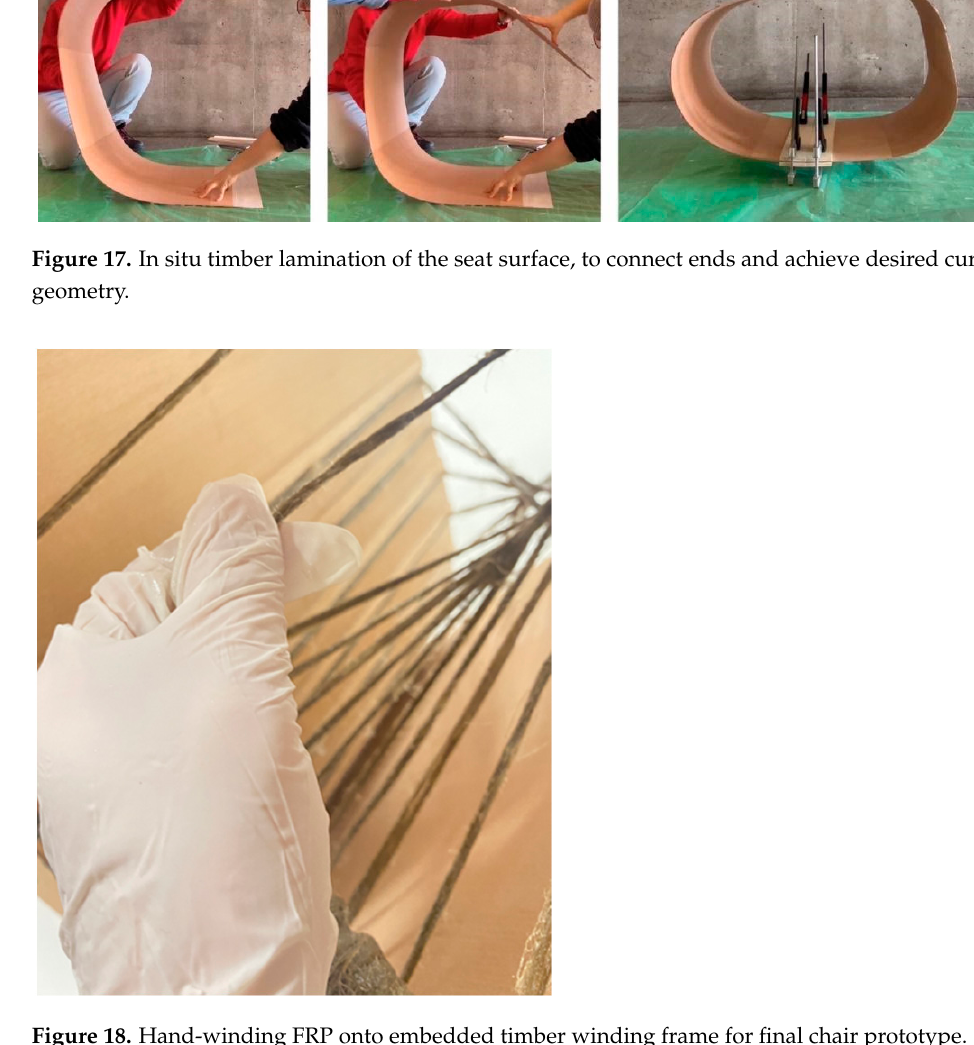
Figure 18. Hand-winding FRP onto embedded timber winding frame for final chair prototype.